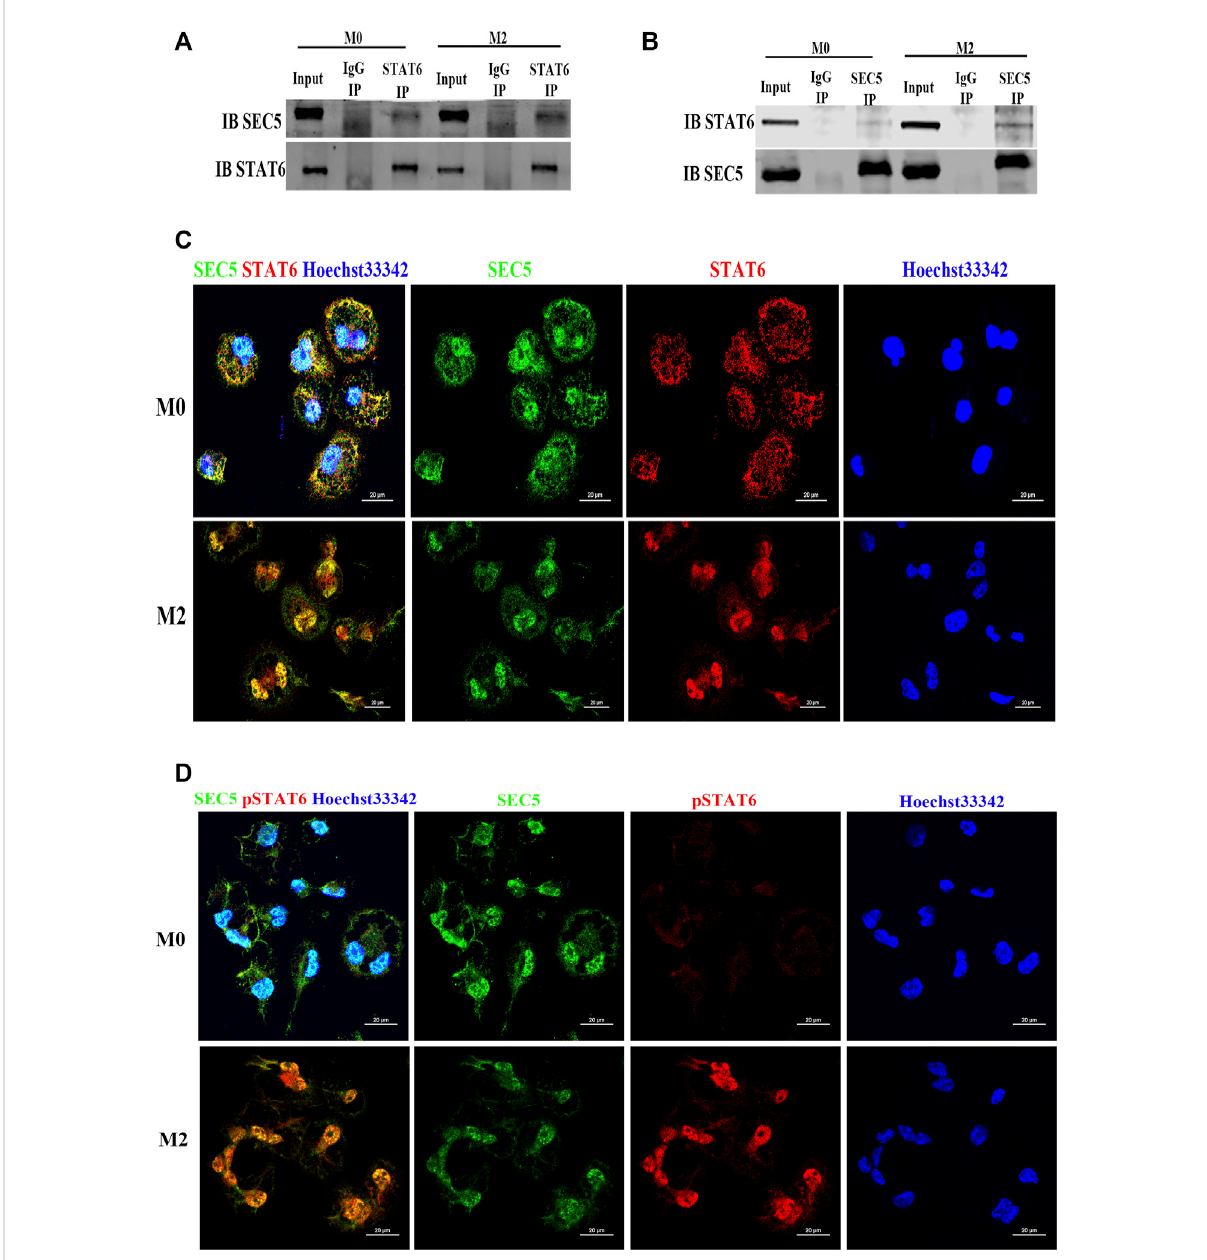
FIGURE 4 SEC5 interacts and colocalizes with STAT6 protein in human M ϕ s. (A) The interaction between SEC5 and STAT6 in THP1-derived M ϕ s was detected by immunoprecipitation (IP) assays in which samples were immunoprecipitated using anti-STAT6 antibody and immunoblotted with anti- SEC5 antibody. (B) The interaction between SEC5 and STAT6 in THP1-derived M ϕ s was detected by IP assays using an anti-SEC5 antibody for immunoprecipitation and an anti-STAT6 antibody for immunoblotting. (C) Double immuno fl uorescence staining of SEC5 and STAT6 in THP1- derivedM ϕ s. (D) Doubleimmuno fl uorescencestainingofSEC5andphosphorylatedSTAT6(pSTAT6)inTHP1-derivedM ϕ s.M0:M0M ϕ s;M2:M0M ϕ s treated with